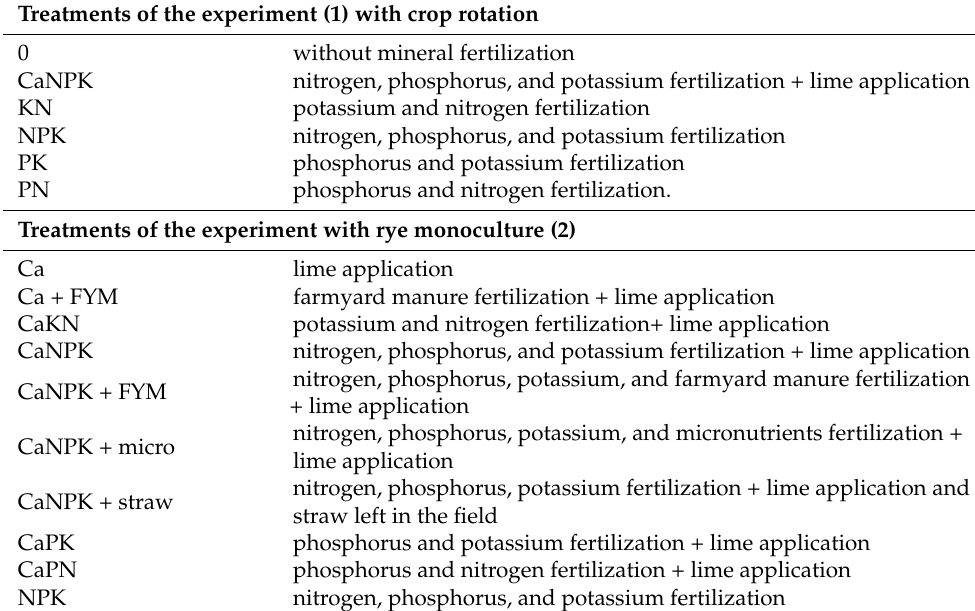
Table 2. Description of the treatments of the experiments (1) with crop rotation and with rye monoculture (2).